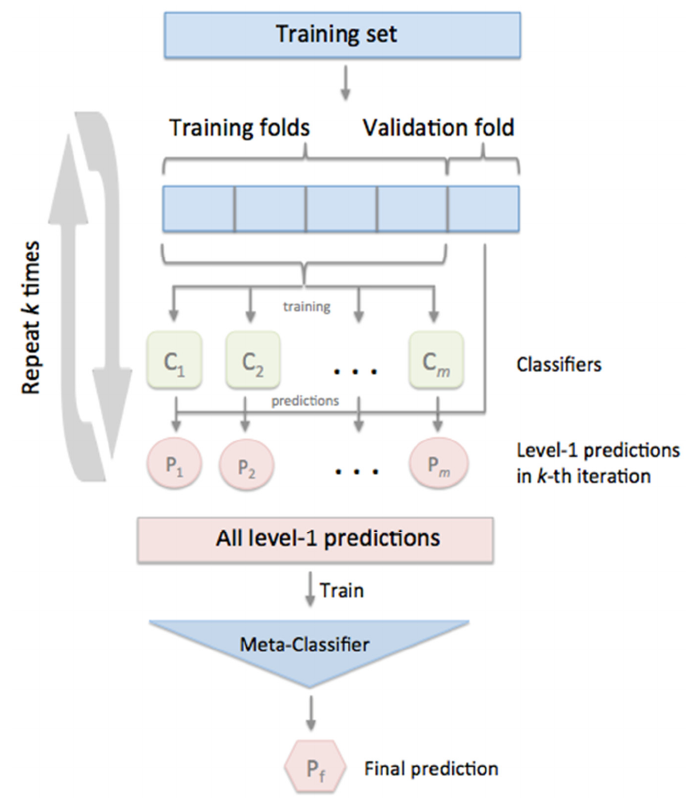
Figure 7. The basic architecture of stacked CV algorithm [35].